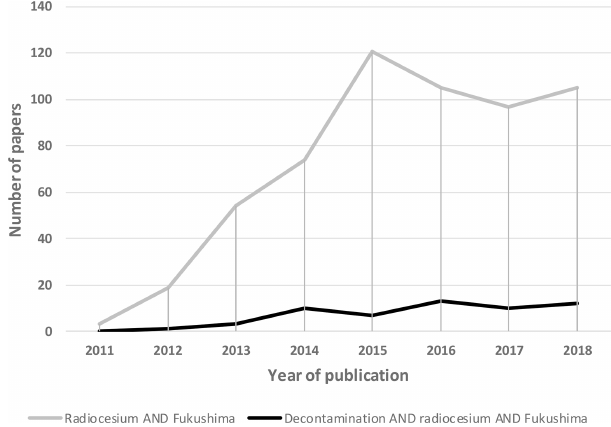
Figure 1. Evolution of the number of studies published on radio- cesium and Fukushima (including or not including a reference to decontamination) in the literature between 2011 and 2018, accord- ing to the Scopus search